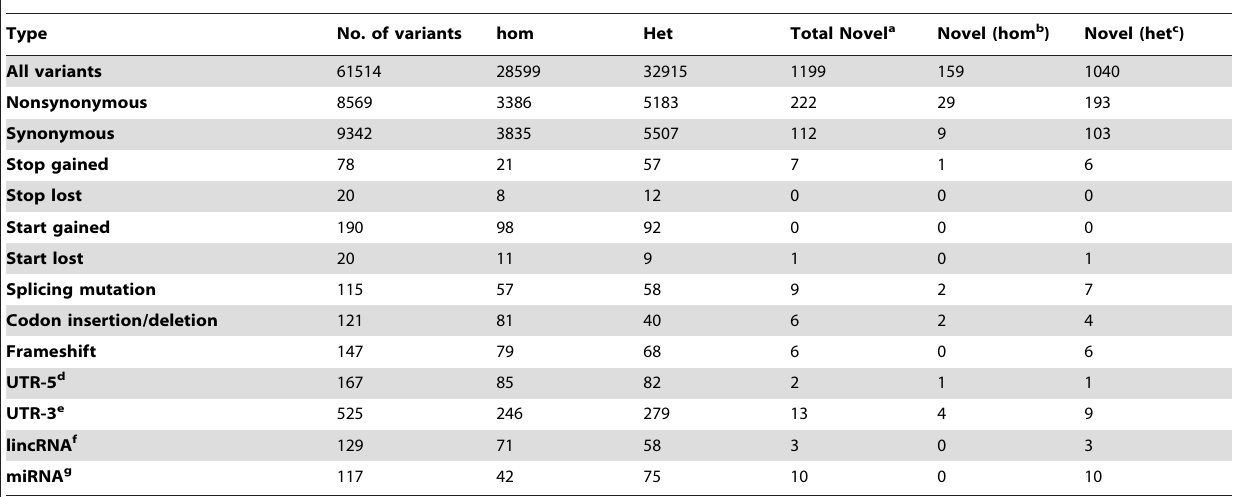
Table 2. Summary of whole-exome sequencing results.